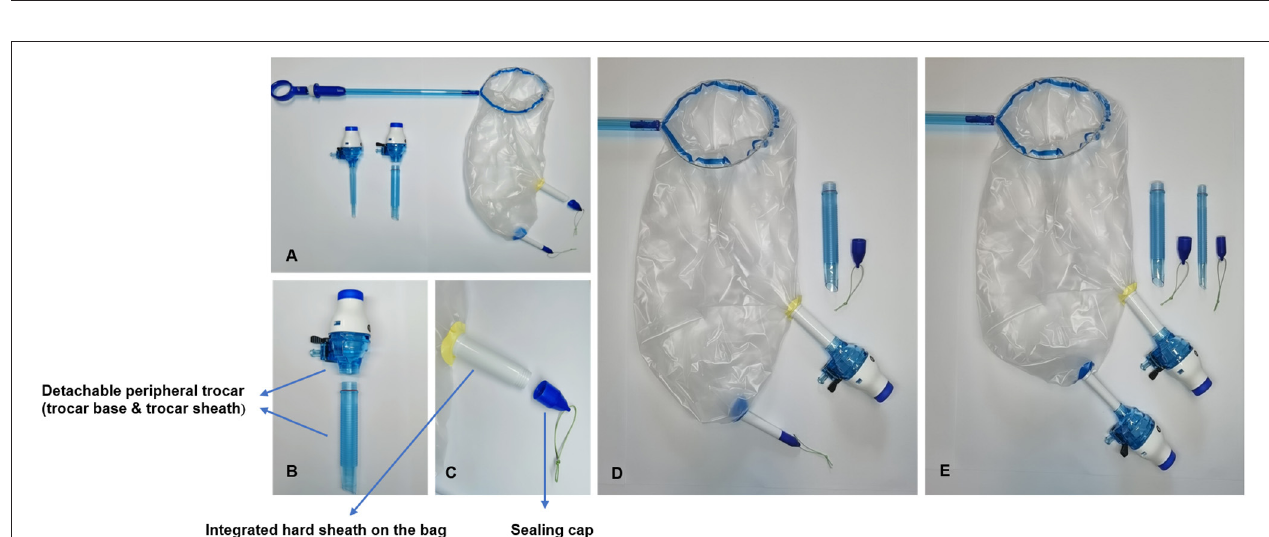
FIGURE 2 | Main components of the novel multi-port containment (NMC) system. (A) The main components of the NMC system include the detachable peripheral trocar and the retrieval bag. (B) Detachable peripheral trocar (trocar base and trocar sheath). (C) Hard sheath on the bag and sealing cap. (D,E) Transposing sealing caps and trocar bases by threaded